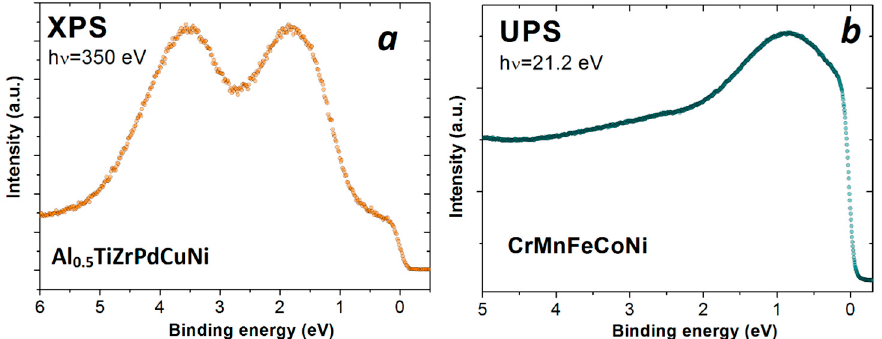
Figure 4. ( a ) XPS of Al 0.5 TiZrPdCuNi magnetic alloy; ( b ) UPS of FCC CrMnFeCoNi Cantor alloy. Split ‐ band structures of VBs of TE ‐ TL MGs and crystalline alloys were observed